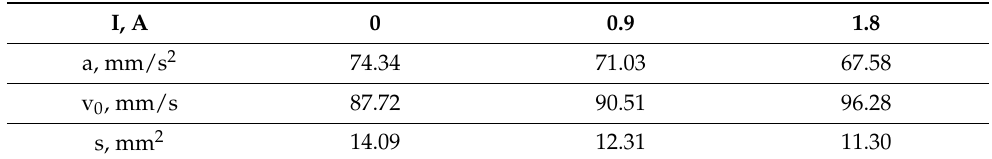
Table 6. Acceleration, velocity, and cross-sectional area of water droplet movement in the channel at different values of the current applied to the solenoid.